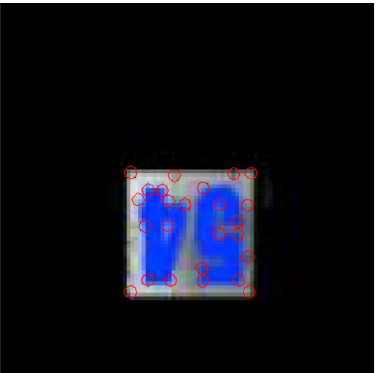
Figure 3. Image of the robot with pixel coordinates 𝑢 = 0, 𝑣 = 0 and rotation angle 𝛼 = 0° with 25 intrinsic points found by the Harris–Stephens corner detector [17].